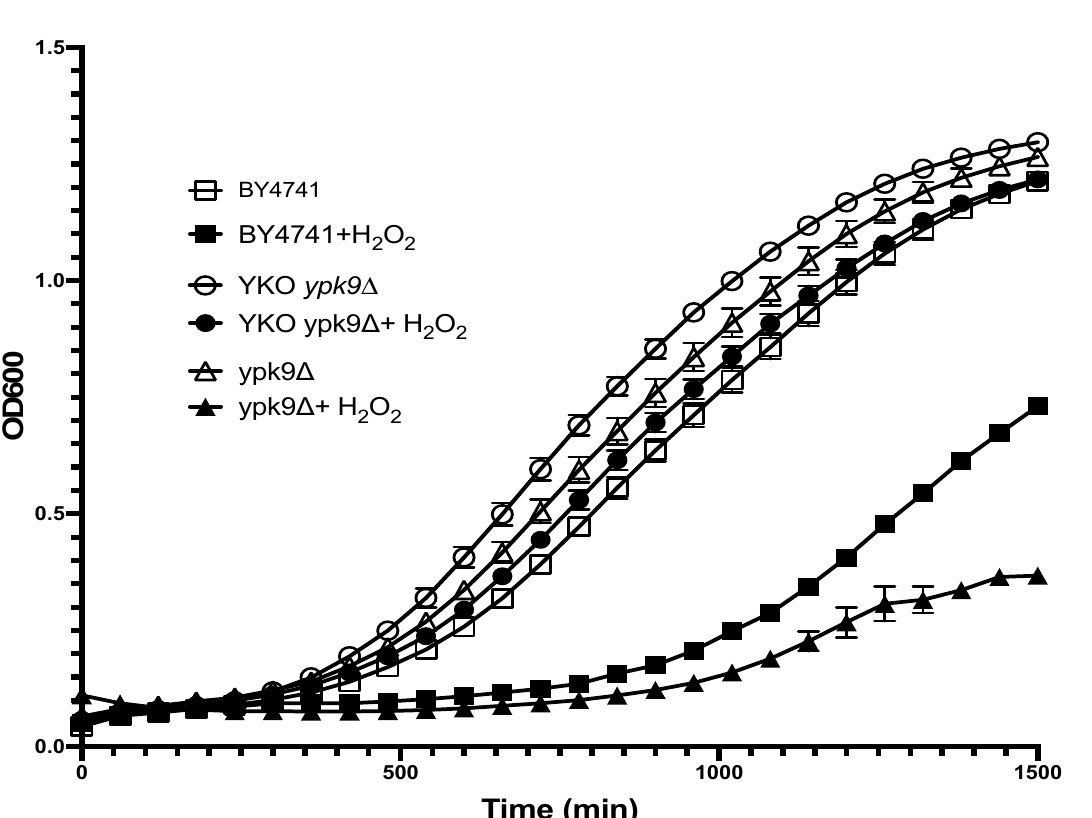
Figure 1. H 2 O 2 sensitivity of the YKO collection and laboratory YPK9 deletion strains. The growth curves of BY4741 COM (squares), the YKO collection’s ypk9 ∆ in BY4741 (circles), and our ypk9 ∆ in BY4741 COM (triangles) were compared in the presence (solid symbols) or absence (open symbols) of 50 µM H 2 O 2 . Differences in growth (see text) were based on OD 600 at mid-log point. Error bars represent the SEM, N = 3.